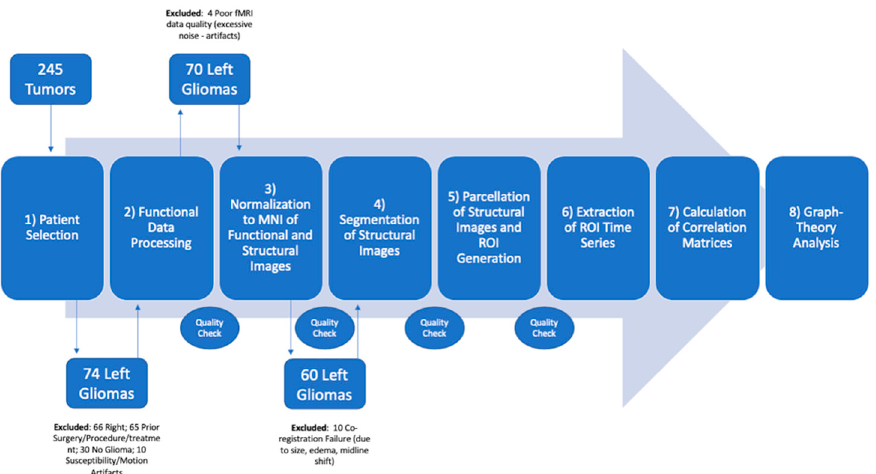
Figure 1. Schematic representation of the pipeline used for patient recruitment, data processing and analysis.